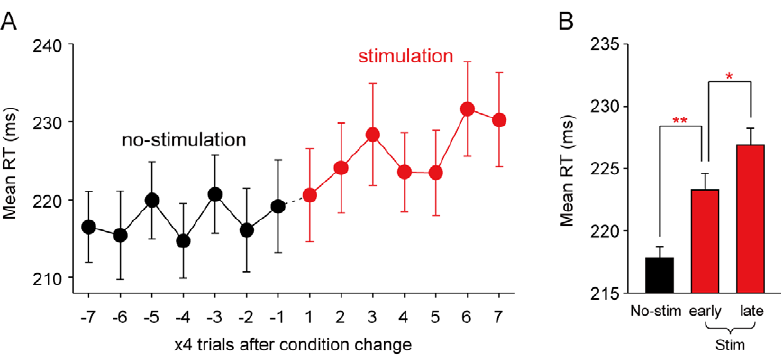
Figure 3. Time course of the change in saccade latency. ( A ) Mean saccade latencies plotted against the number of trials before and after direction-stimulation contingency was reversed. Red plots indicate mean latencies in the stimulation condition. Black plots indicate mean latencies in the no-stimulation condition. Each plot indicates the mean of latencies in 4 trials. ( B ) Mean saccade latency. Trials of the stimulation condition were divided into the early period (the first half of the 36 trials of the condition) and the late period (the latter half of the 36 trials), and the mean saccade latency was calculated for each period. Double and single asterisks indicate a significant difference (P , 0.01 and P , 0.05 respectively, Wilcoxon rank- sum test). Data from monkeys E and D as well as from ipsilateral and contralateral saccades were combined. Experiments with a significantly longer latency in the stimulation condition comprised the sample used for the analysis (ipsilateral saccades, N=12; contralateral saccades, N=8). Error bars indicate s.e.m.